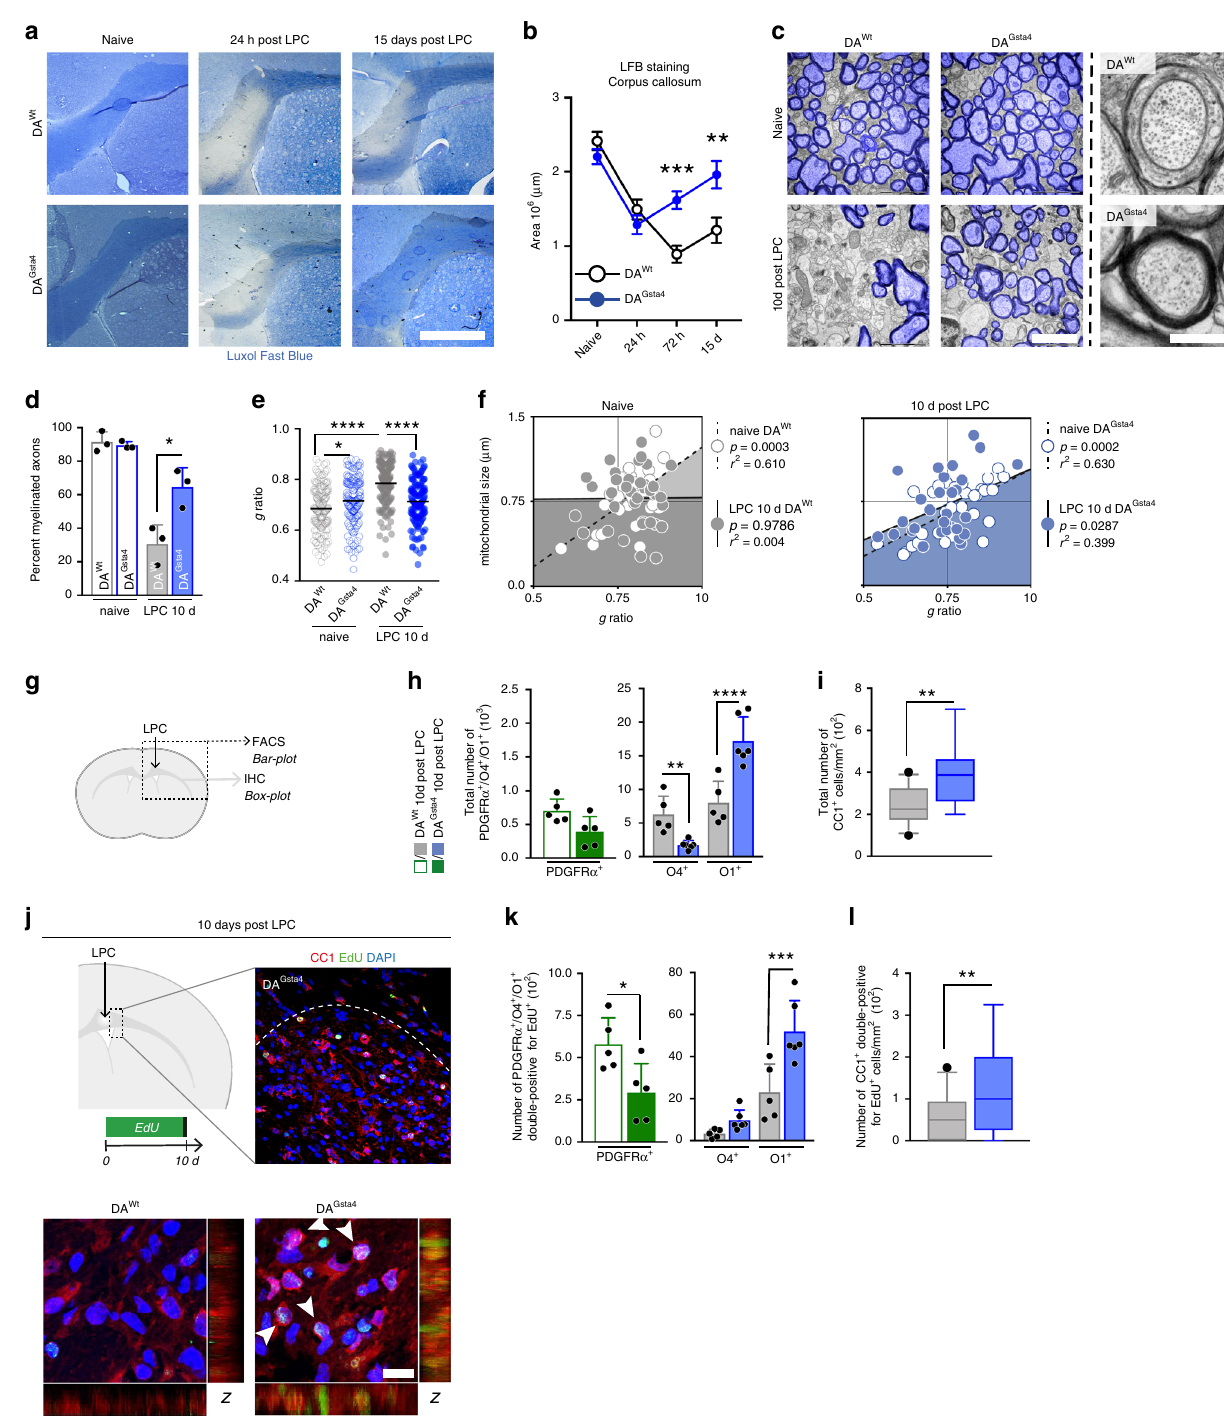
Fig. 5 Gsta4 stimulates axonal remyelination through more ef fi cient OL differentiation. a Corpus callosum sections stained with LFB for evaluation of demyelination, scale-bar 1 mm. b LFB staining following administration of 0.1% LPC (naïve/24h/72h; n = 6, 15d; n = 5). c Representative TEM images of corpus callosum, myelinated axons pseudo-colored in blue, scale-bar 2 μ m and 400 nm. d Percentage of myelinated axons in naïve DA Wt and DA Gsta4 and during remyelination ( n = 3). e g -ratio in naïve DA Wt and DA Gsta4 and during remyelination ( n = 3). f Correlation between g -ratio and axonal mitochondrial size during homeostasis (left) and during remyelination (right) ( n = 30). g Illustration of experimental set-up. h Flow cytometric analysis of total number of PDGFR α + OPCs (green) ( n = 5) and O1 + and O1 + OLs (grey/blue) ( n = 5 + 6). i Immunohistochemically validation of CC1 + OLs in corpus callosum ( n = 5). j Representative corpus callosum images 10 days following LPC, scale-bar 10 μ m. k Number of PDGFR α + , O4 + , or O1 + double-positive for EdU + 10 days after continuous EdU administration. l Number of CC1 + double-positive for EdU + 10 days after EdU administration. All graphs show mean and S.D., apart from i , l showing box and whiskers, indicating values outside 5 – 95 percentile. All statistical analyses were performed with one-way ANOVA, apart from i , l performed with Students ’ two-tailed unpaired t test and f analyzed with two-tailed Pearsons ’ r test. * P < 0.05, ** P < 0.01, *** P < 0.001, **** P <